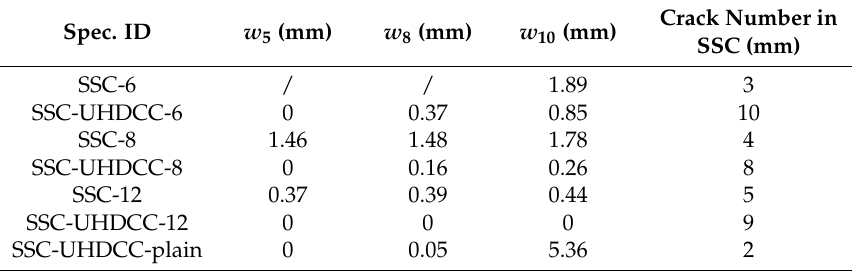
Table 8. Crack width and number.